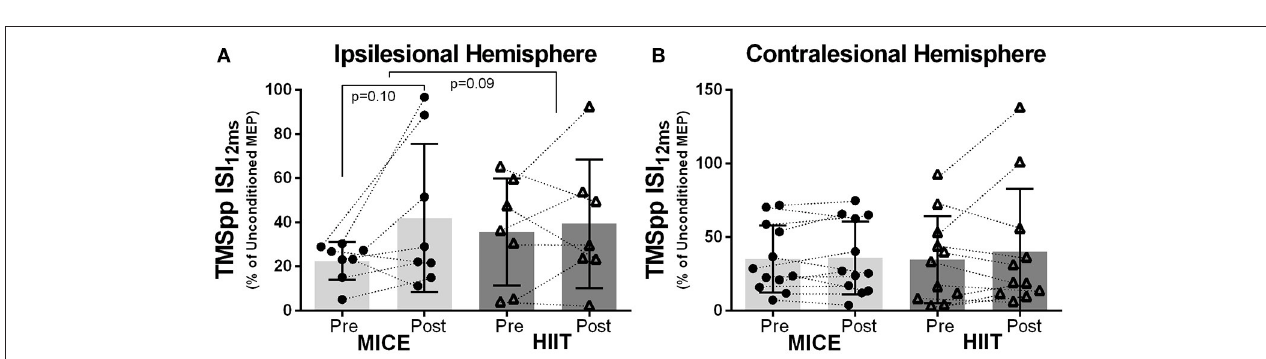
FIGURE 3 | Exercise-induced changes in MEP amplitude: (A) ipsilesional and (B) contralesional hemispheres after MICE and HIIT using TMS paired-pulse with an interstimulus interval of 12ms (ISI 12ms ) between